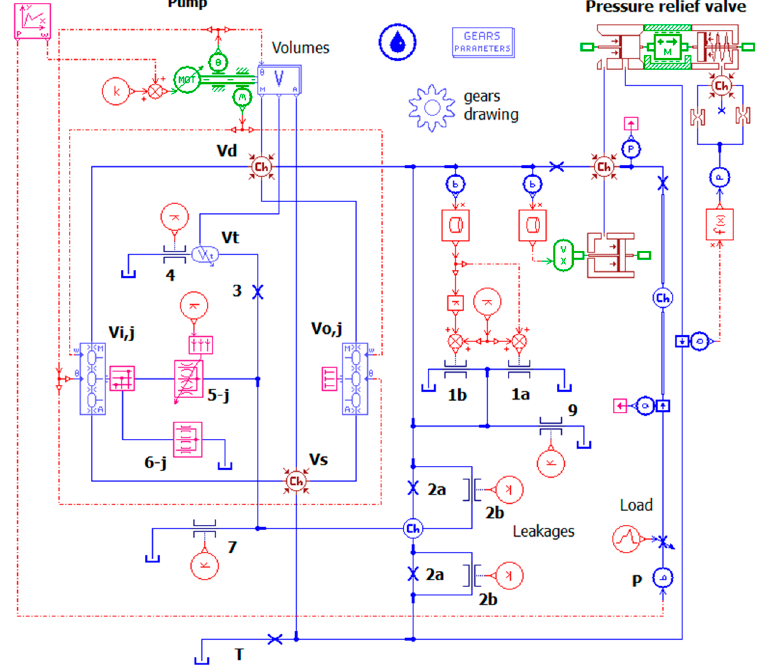
Figure 17. Complete pump model in LMS Amesim.